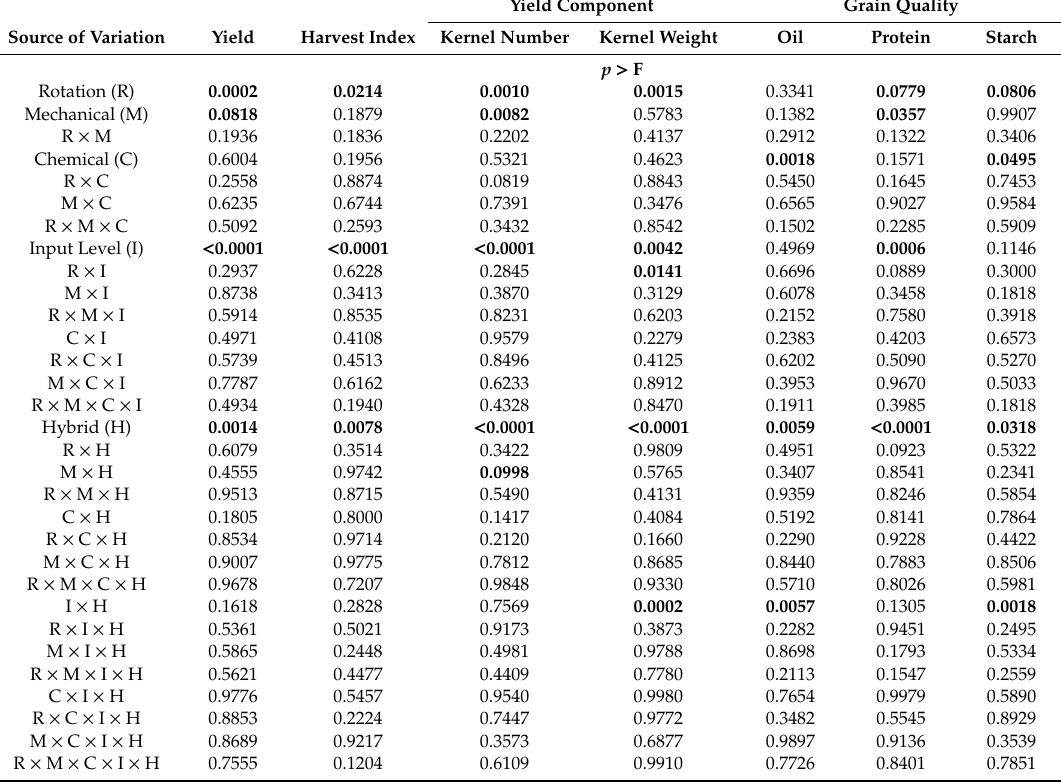
Table 7. Tests of fixed sources of variation on corn grain yield, harvest index, yield components, and grain quality as a ff ected by two crop rotations, two mechanical and three chemical residue managements, two input levels, and two hybrids at Champaign, Illinois during 2017 and